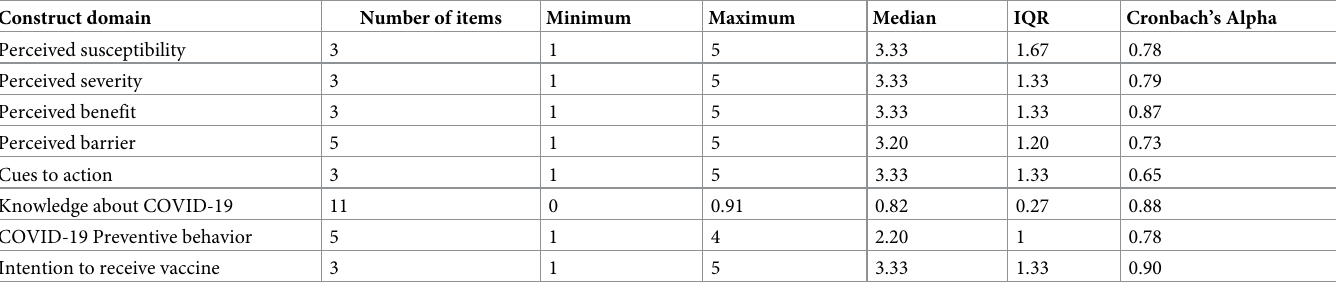
Table 3. Distribution of health belief on intention to receive COVID-19 vaccine among school teachers in Gondar city, North West Ethiopia, 2021. Construct